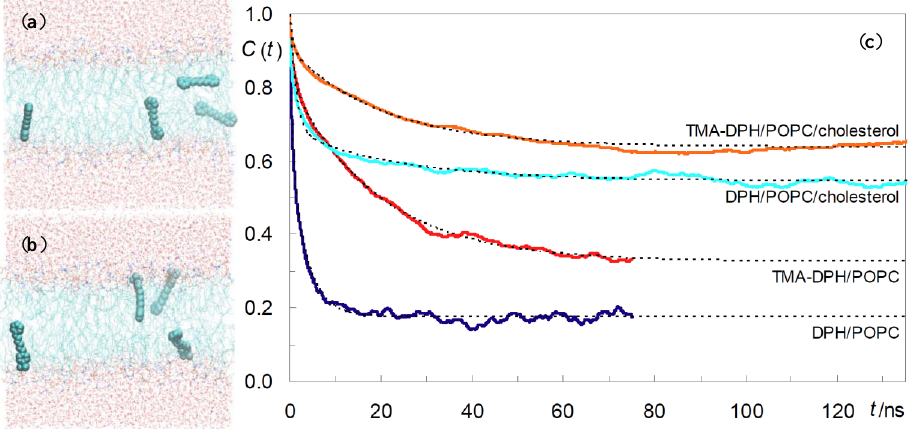
Figure 2. ( a ) Snapshot of a simulation of 4 DPH molecules in a POPC bilayer; ( b ) Same as ( a ), but with 4 TMA-DPH molecules; ( c ) Rotational autocorrelation curves C ( t ) for the long axis of DPH and TMA-DPH in POPC and POPC / 20 mol% Chol. Dotted lines are biexponential fits with a residual component. Reprinted from [32] with permission from Elsevier. Copyright 2016